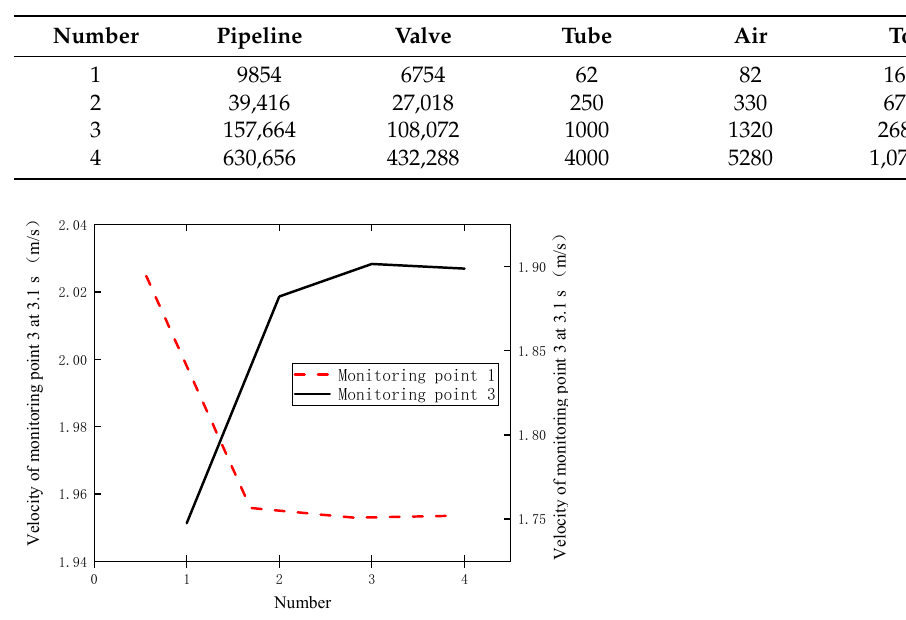
Table 1. Table of different mesh sizes.